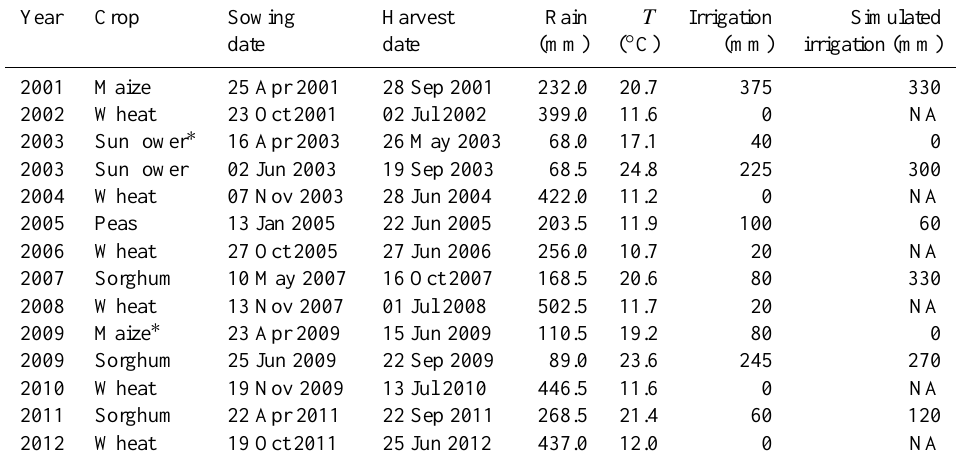
Table 2. 2001–2012 crop succession. T and rain are the mean temperature and cumulative precipitation, respectively, over the crop